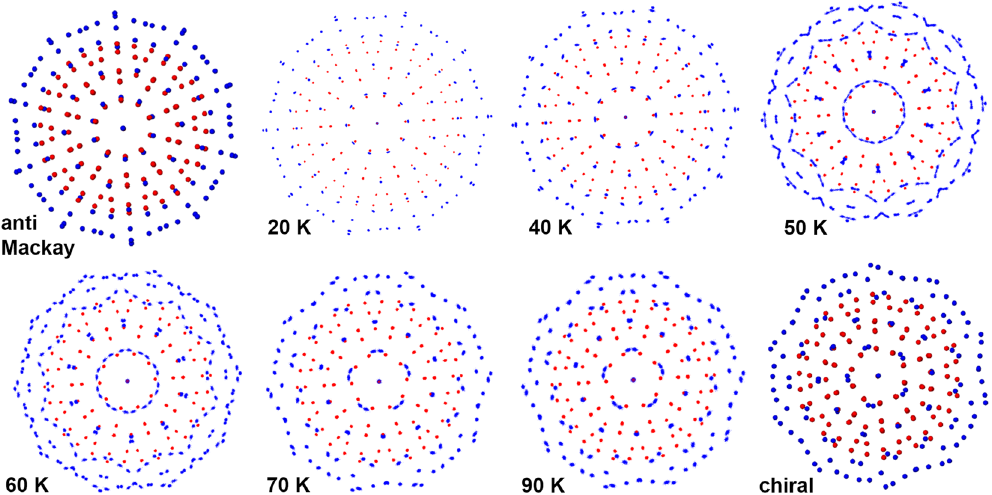
Figure 4. Structure of Ag Cu as a function of temperature (Ag in blue, Cu in red). The images labelled anti 132 147 Mackay, chiral are for the perfect anti-Mackay, chiral icosahedron. Chiral stacking begins to appear at 50 K.